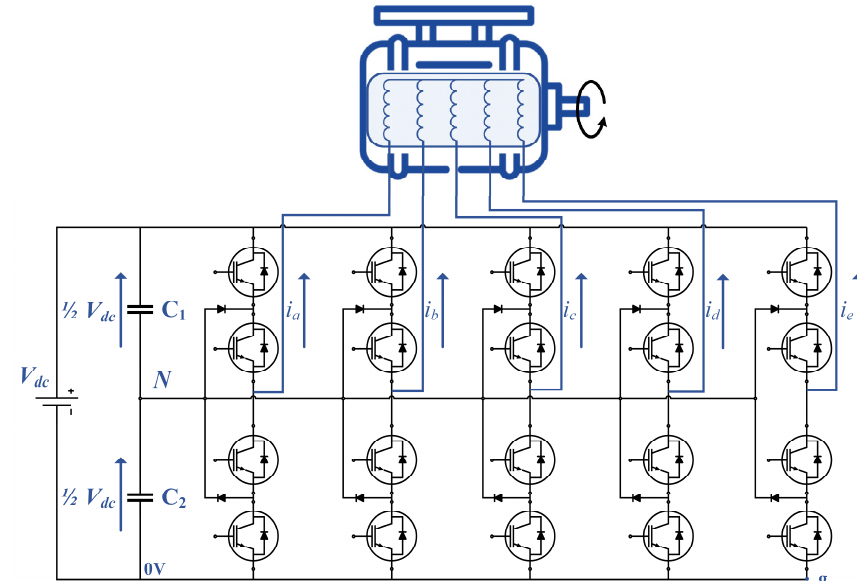
Figure 9. Three-level converter topology for a five-phase voltage source drive. The 4L-NPC uses an arrangement of three capacitor blocks and six power switches per leg, connected through diodes to the midpoint of the capacitor blocks, as illustrated in Figure 10.